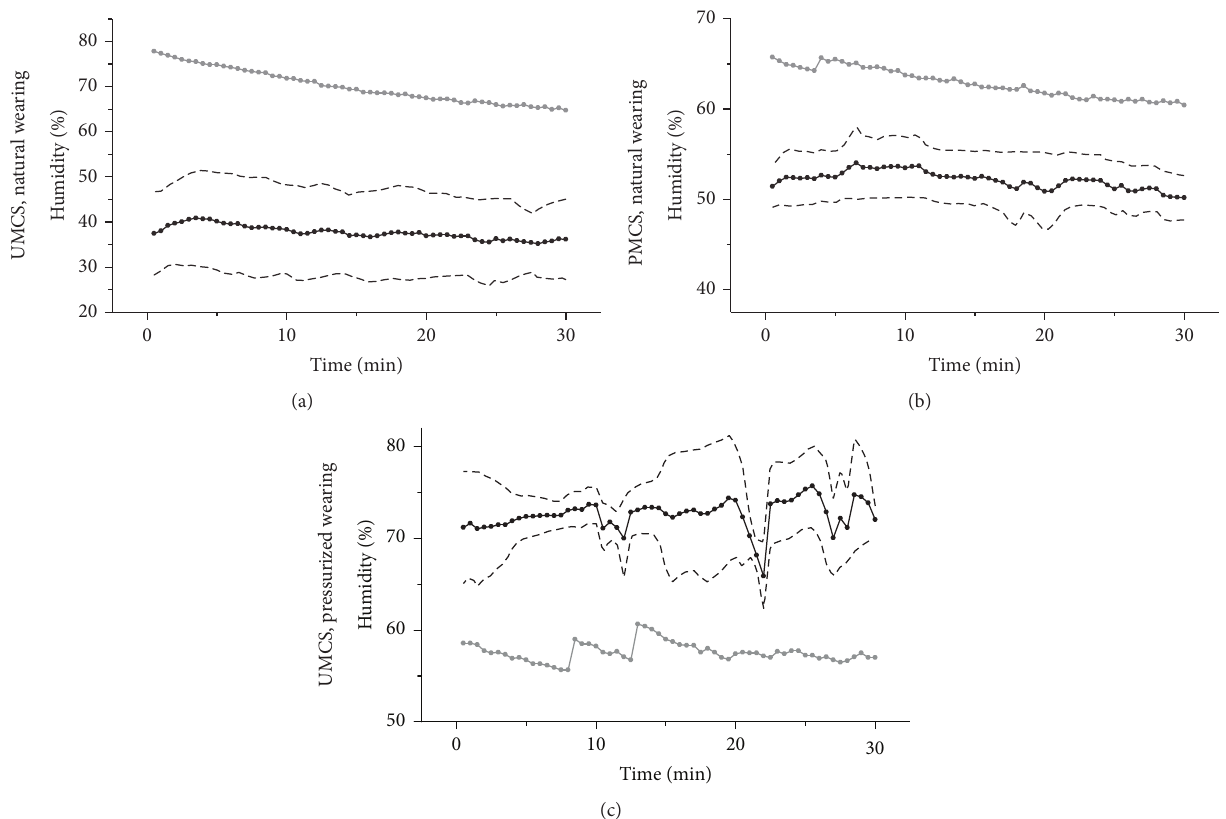
Figure 6: Measured periocular humidity and calculated condensation humidity. Measured periocular humidity (black line), ± 1 standard deviation of humidity measurements (dash line), and calculated condensation humidity (gray